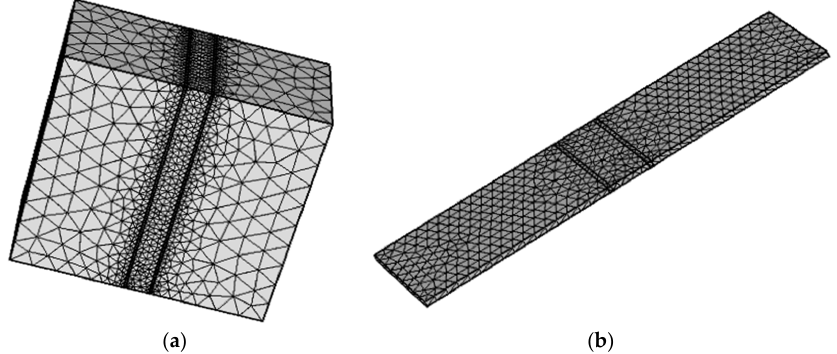
Figure 3. Meshing strategies for computational domain: ( a ) the surface of whole simulation domain; ( b ) the surface of the damaged coating sample.